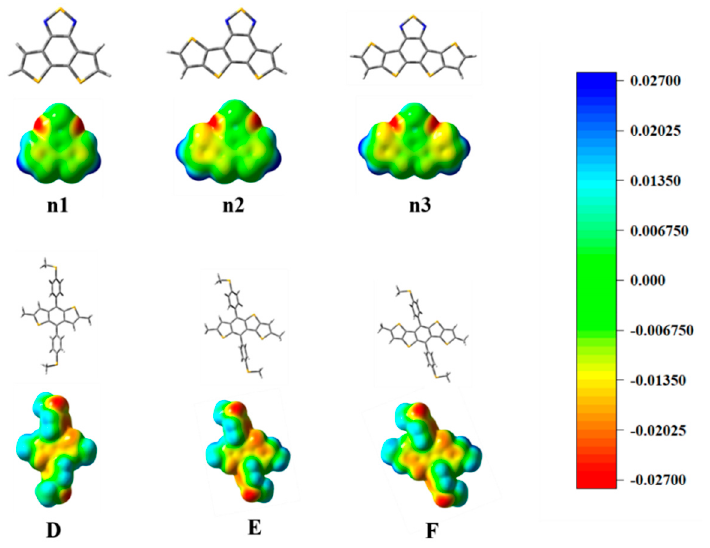
Figure 3. The optimized geometry and ESP distributions (electron density isosurface, 0.001 au) on the n1, n2, n3, D, E, and F models.